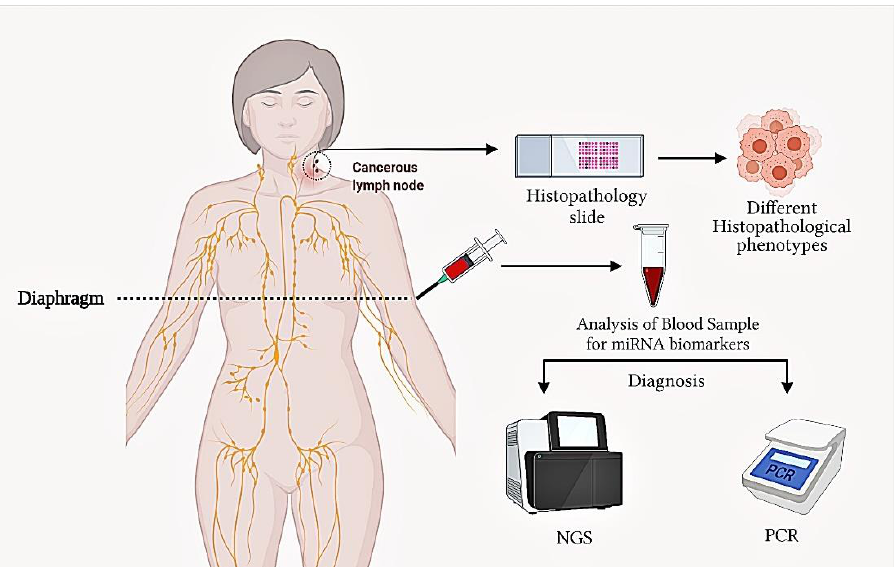
Figure 2. Cancerous lymph node and blood diagnosis for DLBCL by histopathological procedures, PCR and next generation sequencing (NGS).